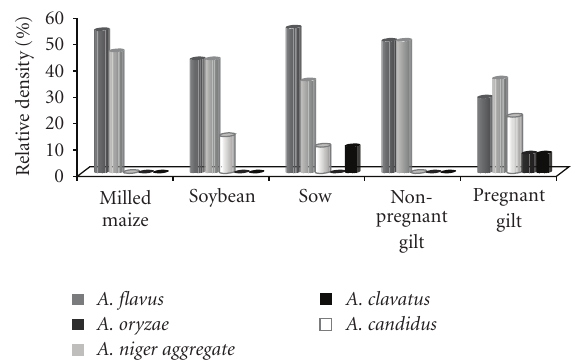
Figure 2: Relative density (%) of Aspergillus spp. isolated from raw materials and finished feed for sows at di ff erent reproductive stages.